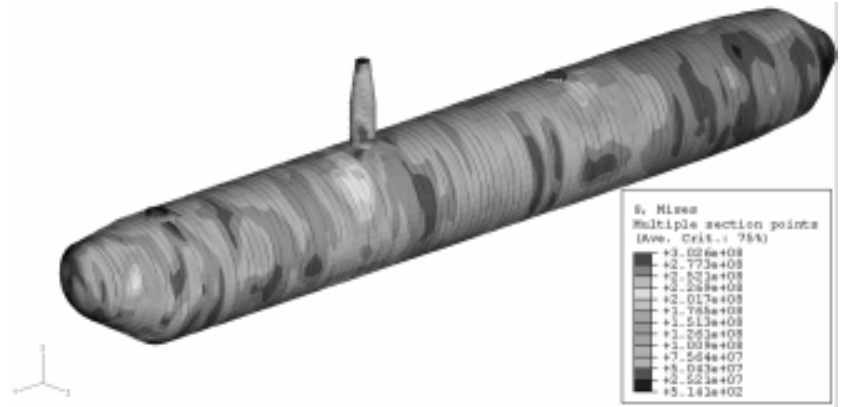
Fig. 12. Stress distribution at t = 0.04